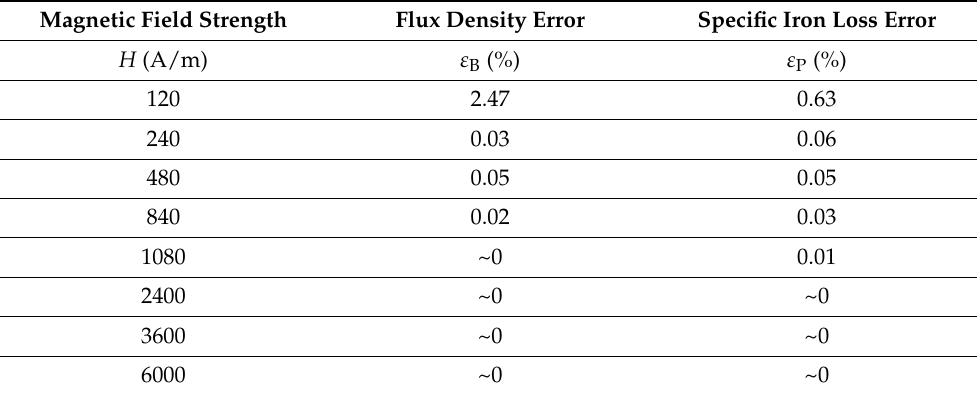
Table 2. The relative errors obtained during model tuning (at 50 Hz, strips cut at an angle of 0